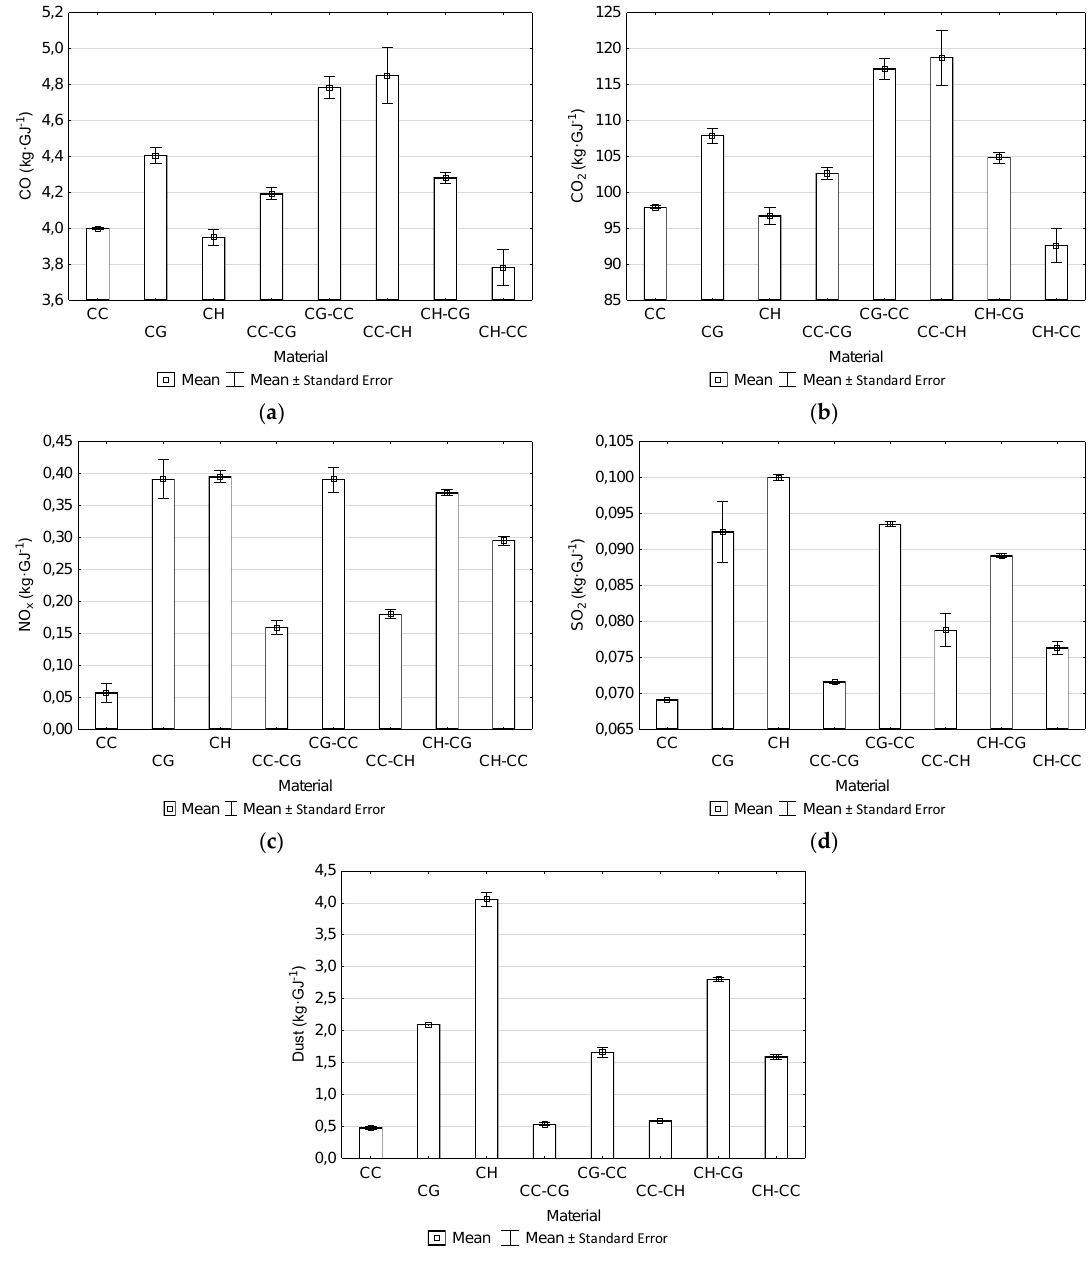
Figure 4. Emission factors per energy unit for the tested materials (kg·GJ -1 dry mass): ( a ) CO; ( b ) CO 2 ; ( c ) NO x ; ( d ) SO 2 ; ( e ) dust.